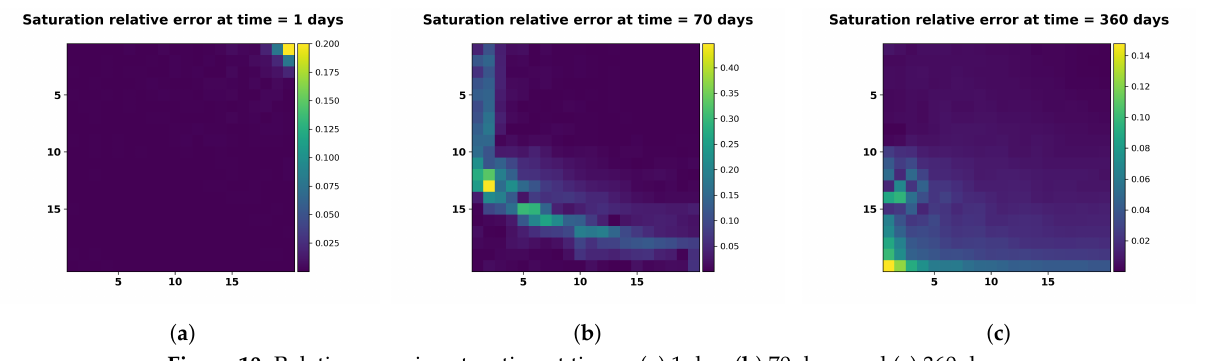
Figure 9. Relative error in pressure at time = ( a ) 1 day, ( b ) 70 days and ( c ) 360 days.